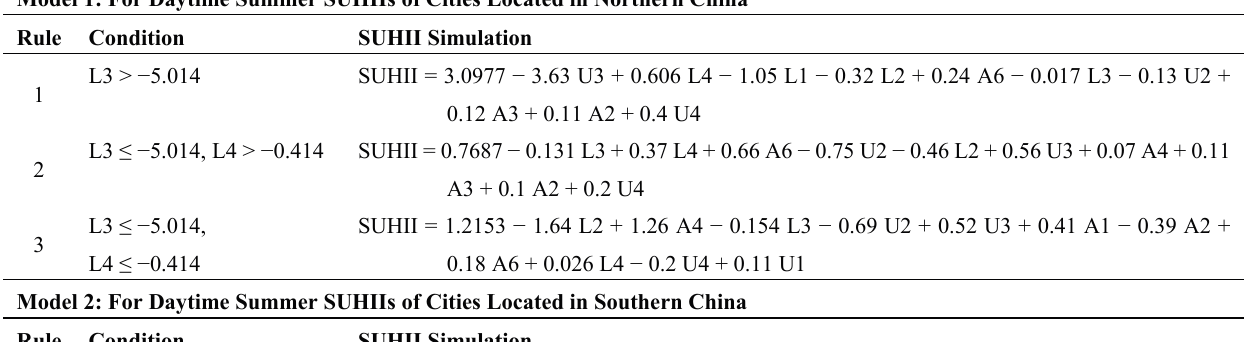
Table 3. Sub-models for the rule-based SUHII simulation (Unit: